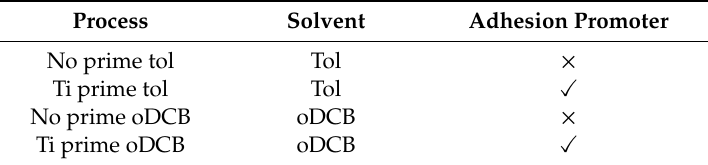
Table 1. Devices were fabricated following four di ff erent processes. No prime tol and no prime oDCB are processes without adhesion promoter, using as solvent toluene or oDCB respectively. During Ti prime tol and Ti prime oDCB processes the samples were treated with adhesion promoter